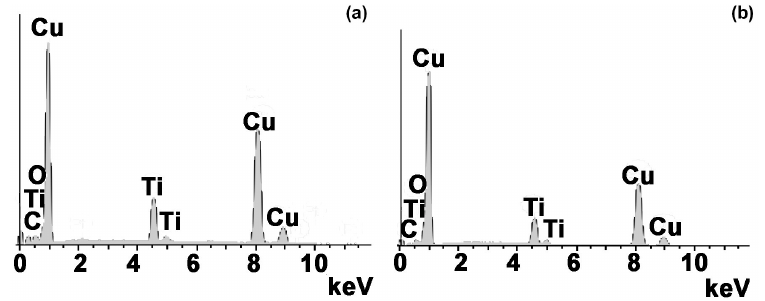
Figure 2. Typical EDS analyses acquired from particles presented in Figure 1e (Cu–Ti–C) in ( a ) and 1f (Cu–TiH2–C) in ( b ), both with 20 vol % TiC. Table 1. EDS analysis of the ball milled powders with 20 vol % of TiC reinforcement particles. Composite